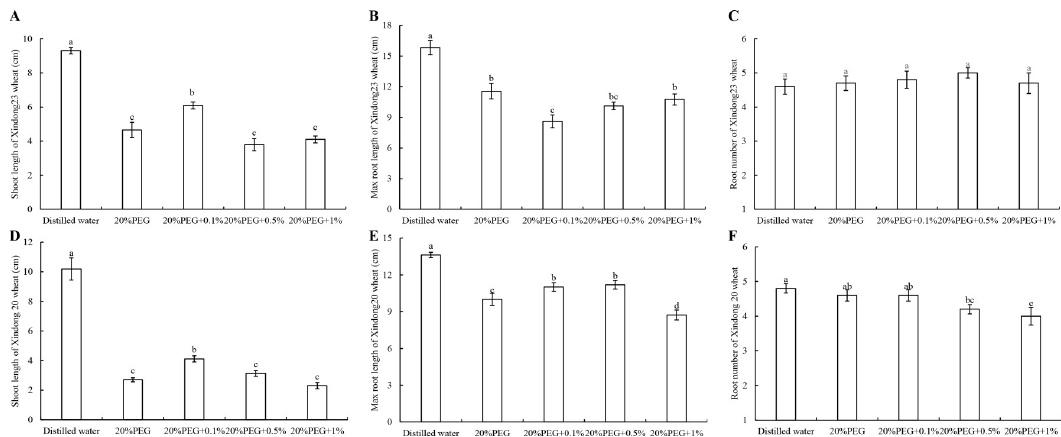
Fig 7. Effects of exogenous xanthohumol addition on germination rate of wheat seeds under PEG-6000-simulated drought stress. Note: A, B, and C represent the shoot length, max root length, and root number of Xingdong23 wheat, respectively. D, E, and F represent the shoot length, max root length and root number of Xingdong20 wheat, respectively. Different lowercase letters represent significantly different at p < 0.05.